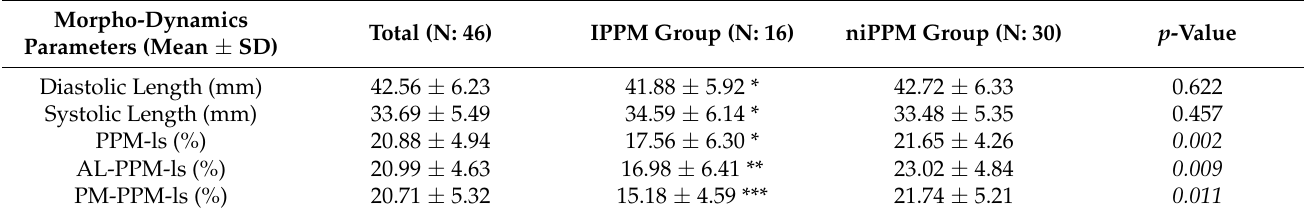
Table 3. Length and longitudinal strain values of the PPMs.